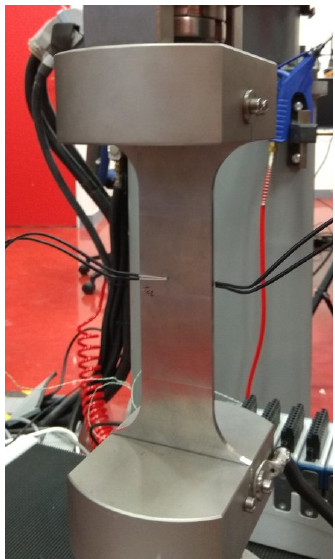
Figure 1. Experimental configuration of a PVR test with two